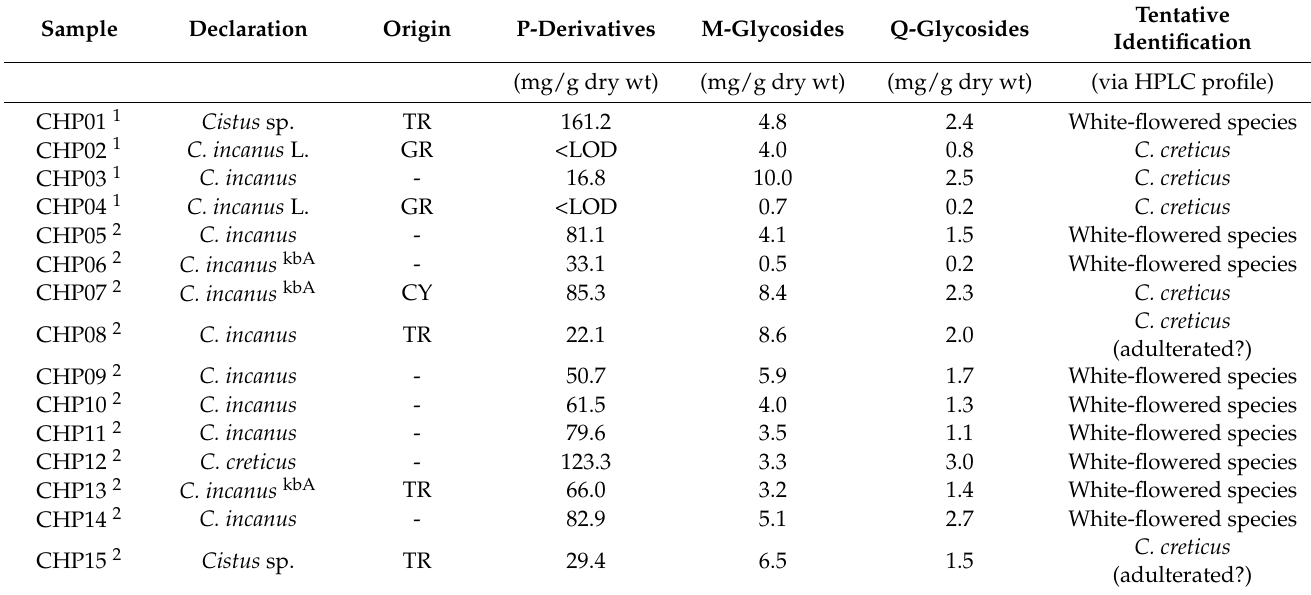
Table 2. Designation and geographical origin (when indicated) of the 15 commercial trade samples purchased from different pharmacies 1 or health retailers 2 (kbA = controlled organic cultivation) and their contents of punicalagin derivatives and myricetin and quercetin glycosides (mg/g dry